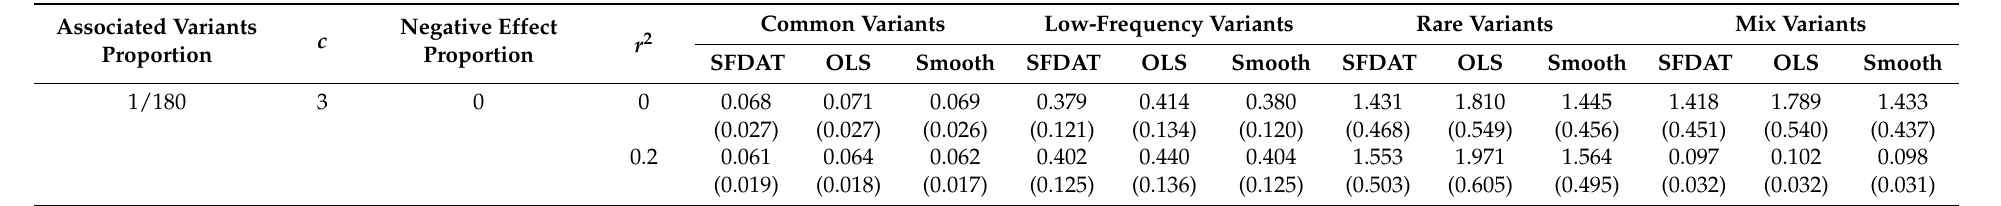
Table 2. The means and standard errors (in the parenthesis) of ISE 0 for association analysis of simulated quantitative trait based on SFDAT, OLS and Smooth on linkage equilibrium and linkage